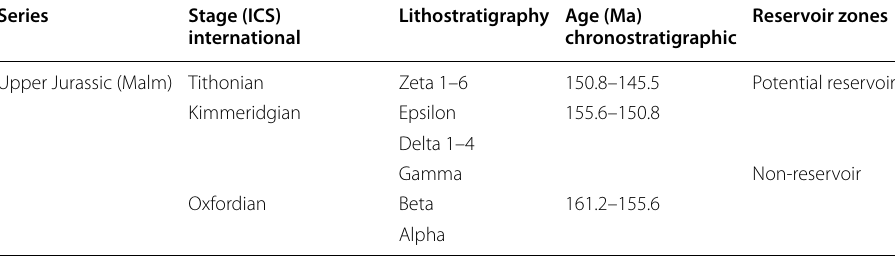
Table 1 Stratigraphic overview of the Upper Jurassic carbonates in Southern Germany Series Stage (ICS)